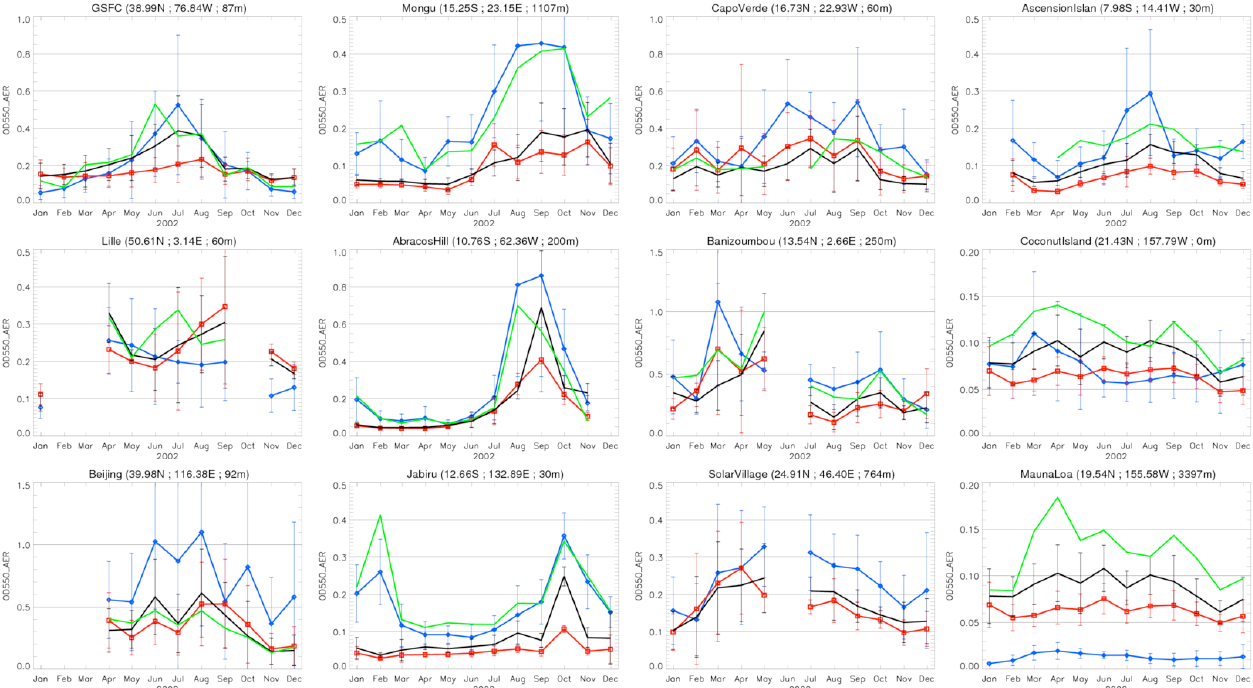
Fig. 8. AOD at 550nm at selected AERONET stations. Model AOD with initial emissions or first guess (FG, red line) and with final emissions or analysis (AN, black line) are illustrated as well as the MODIS AOD (green) and the AERONET AOD (blue). Stations representative of anthropogenic emissions of fossil fuel and sulphate are Goddard Space Flight Centre (38.99 ◦ N, 76.84 ◦ W), Lille (50.61 ◦ N, 3.14 ◦ E) and Beijing (39.98 ◦ N, 116.38 ◦ E). For biomass burning the selected stations are Mongu (15.25 ◦ S, 23.15 ◦ E), Abracos Hill (10.76 ◦ S, 62.36 ◦ W) and Jabiru (12.66 ◦ S, 132.89 ◦ E) whereas for desert dust the stations are Cape Verde (16.73 ◦ N, 22.93 ◦ W), Banizoumbou (13.54 ◦ N, 2.66 ◦ E) and Solar Village (24.91 ◦ N, 46.4 ◦ E). Finally, the stations dominated by sea salt aerosols are Ascension Island (7.98 ◦ S, 14.41 ◦ W), Coconut Island (21.43 ◦ N, 157.79 ◦ W) and Mauna Loa (19.54 ◦ N, 155.58 ◦ W).